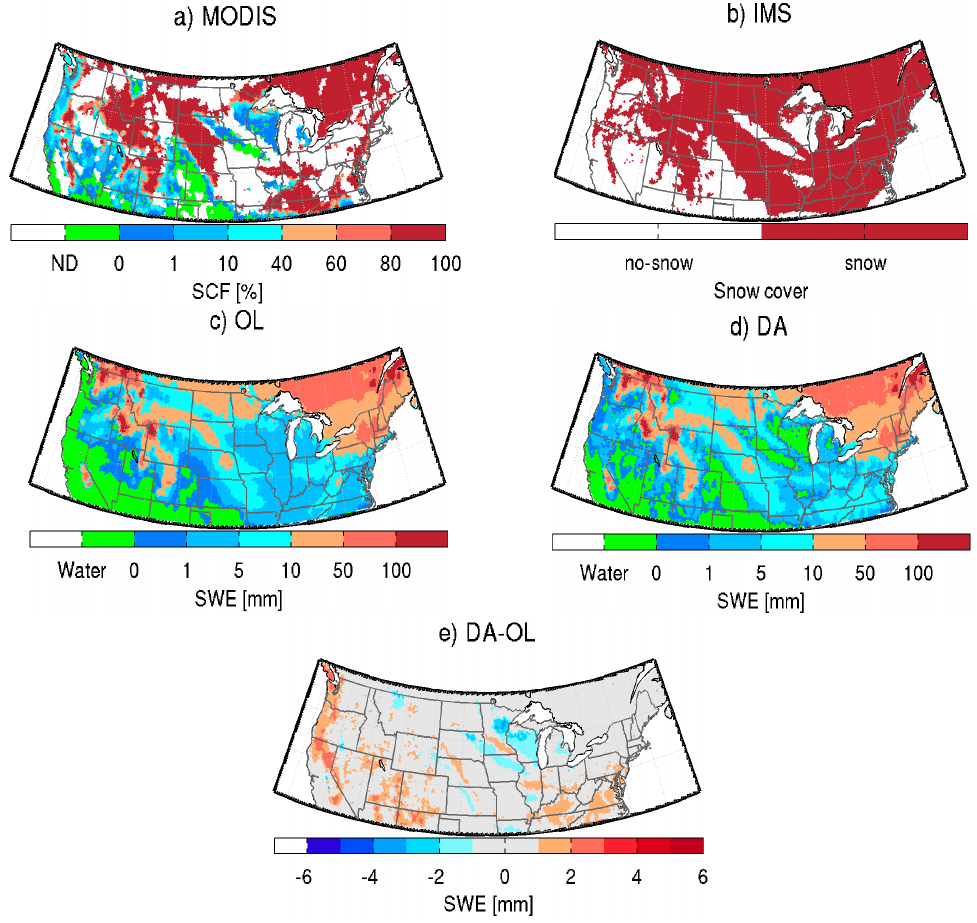
Figure 4. Maps of ( a ) MODIS snow cover (%); ( b ) IMS snow cover; ( c ) open-loop (OL) (model control run) SWE (mm); ( d ) model analysis (DA) SWE (mm) and; ( e ) the difference between DA and OL SWE (mm) for 17 January 2003.